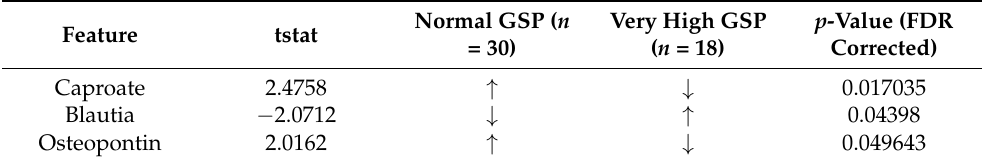
Table 5. Features which demonstrate differential responses between normal and very high GSP levels; Normal GSP = 200–285; Very high GSP = >400. Two-tailed student’s t- test. Arrows ( ↑ / ↓ ) represent features that were increased/decreased in the corresponding population. An FDR corrected p -value is shown in the last